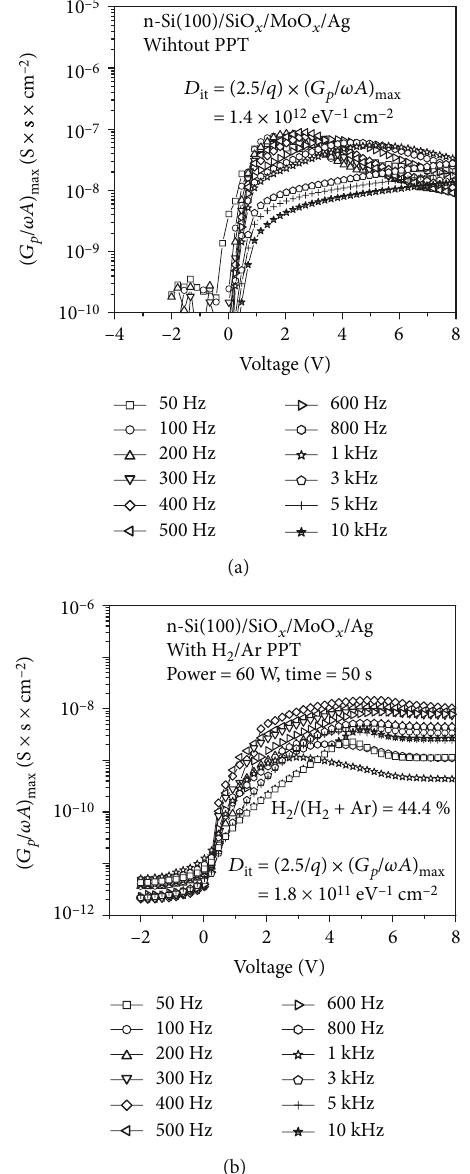
SiO /MoO Figure 5: D it of n-Si(100)/ x x /Ag capacitors (a) with and /Ar PPT extracted from the conductance method. (b) without H 2 The conductance of n-Si(100)/ SiO x /MoO x /Ag capacitors as a function of frequency was measured and plotted as G p / ω A versus voltages by biasing the Si surface in depletion